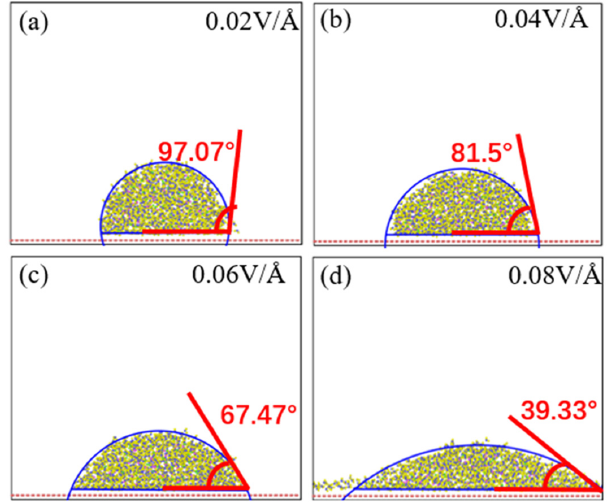
Figure 9. Contact angle of physiological saline under different electric field intensities ( a ) 0.02 V/Å, ( b ) 0.04 V/Å, ( c ) 0.06 V/Å, and ( d ) 0.08 V/Å.